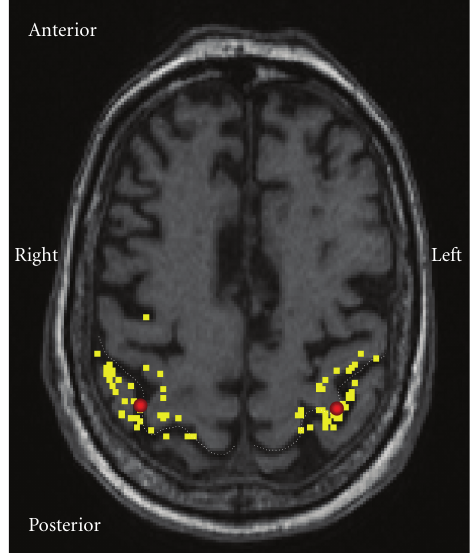
Figure 1: Motor cortex representation area of a control patient. TMS was focused at the “hotspot” of thenar muscle representation on the primary motor cortex (M1). The yellow dots present stimulation locations during the mapping of the hotspot in the vicinity of M1. The red spots indicate the hotspots, which were located within normal variation in each group